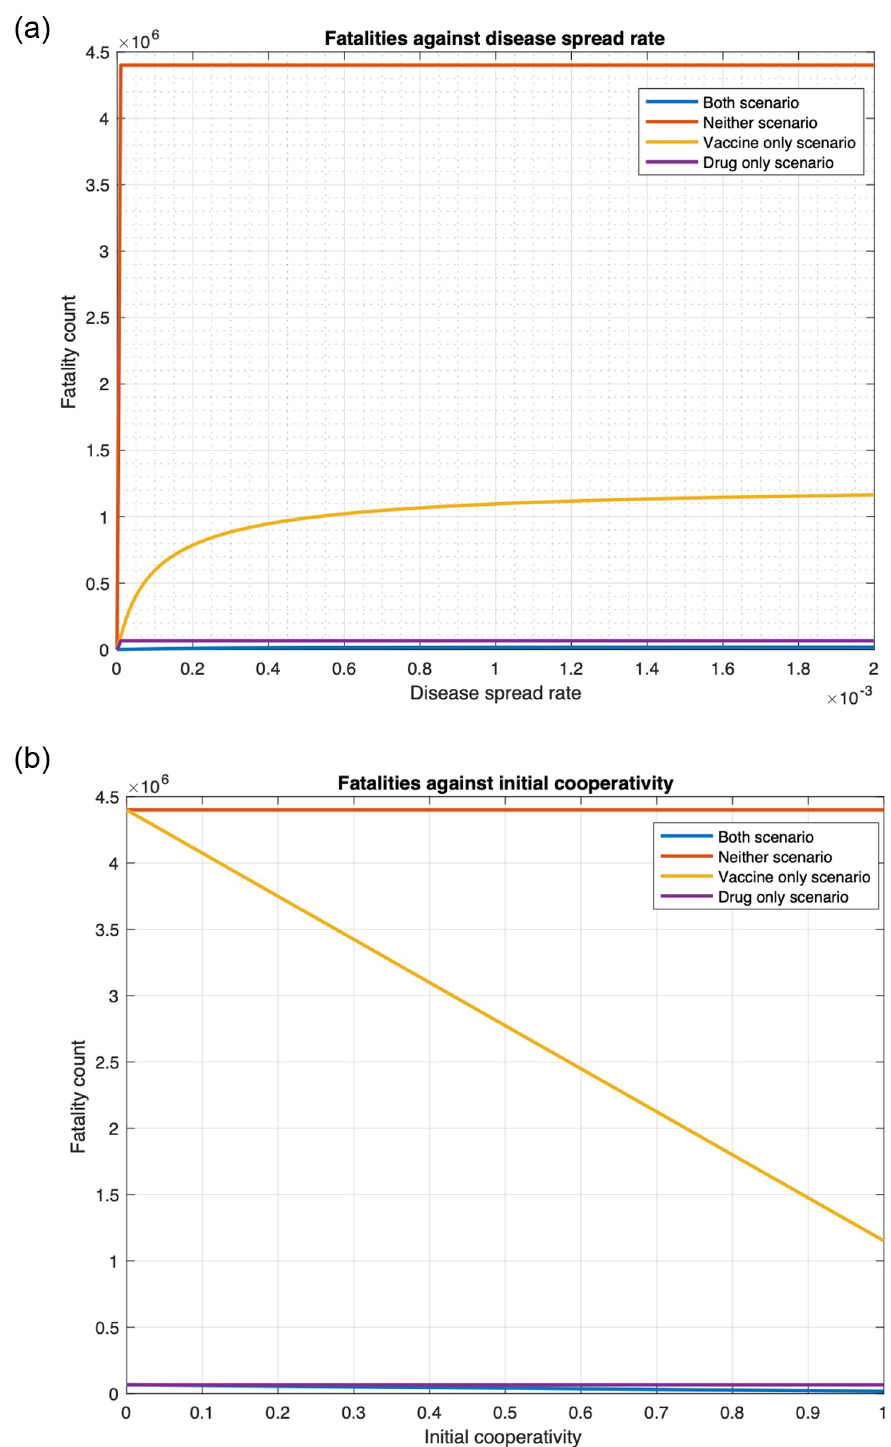
Fig 14. Fatalities under four countermeasure application scenarios for various values of infection spread rates and initial cooperativities for single cluster. (a) Relationship between fatality and disease spread rate. (b) Relationship between fatality and initial